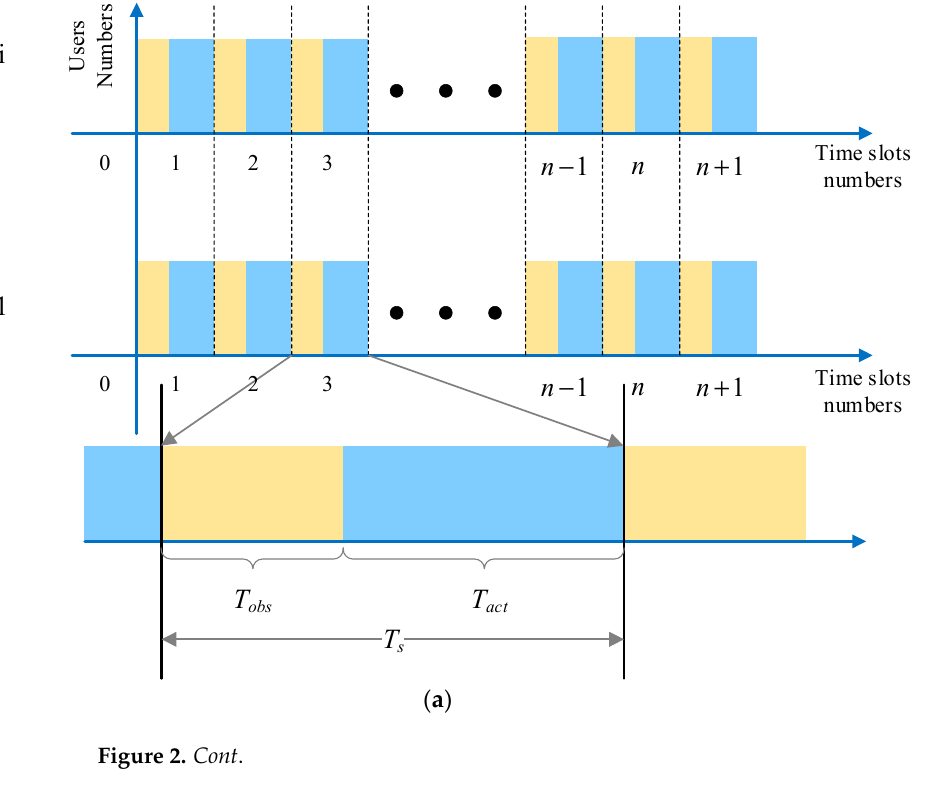
Figure 1. Schematic diagram of system structure (take